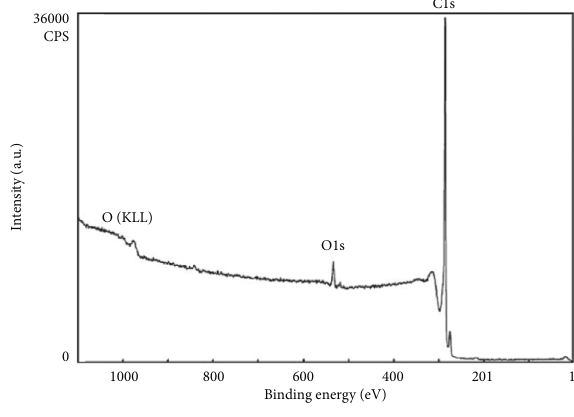
Figure 5: XPS results of GO. Table 6: Chemical composition of selected GO.